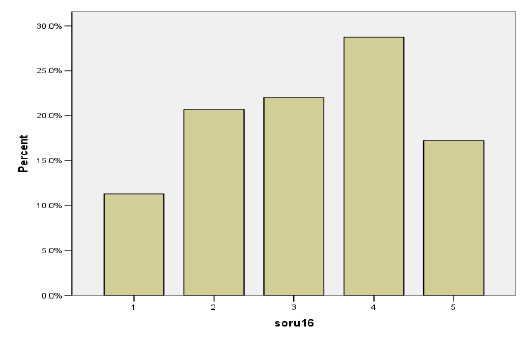
Figure 11. Are contemporary issues related to accounting courses discussed in Turkish universities? Q21: Should accounting education programs primarily focus on national and international exams organized for employment opportunities? Concerning this question, 5.7% of students